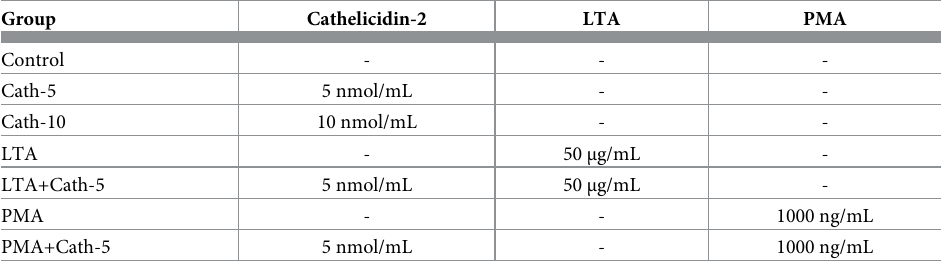
Table 1. Treatment